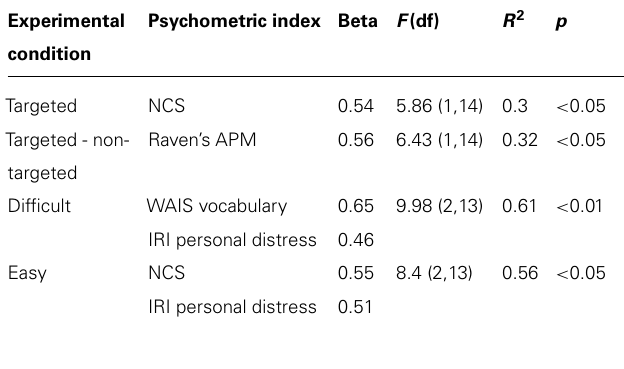
Table 2 | Overview of psychometric indexes significantly accounting for communicative success in the different experimental